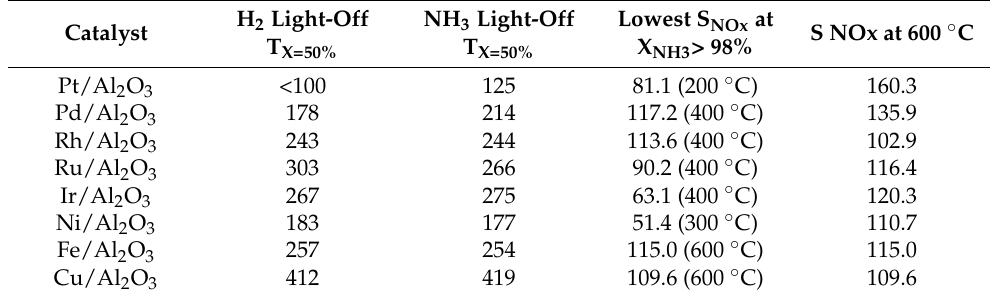
Table 3. Comparison of the catalytic performance of different metal-based catalysts tested in this